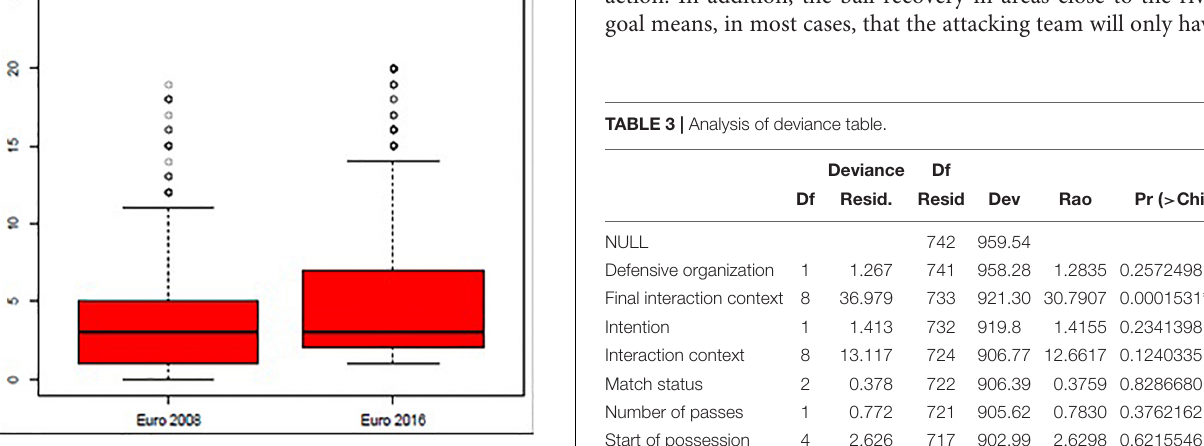
FIGURE 3 | Boxplot of Number of Intervening by competition.